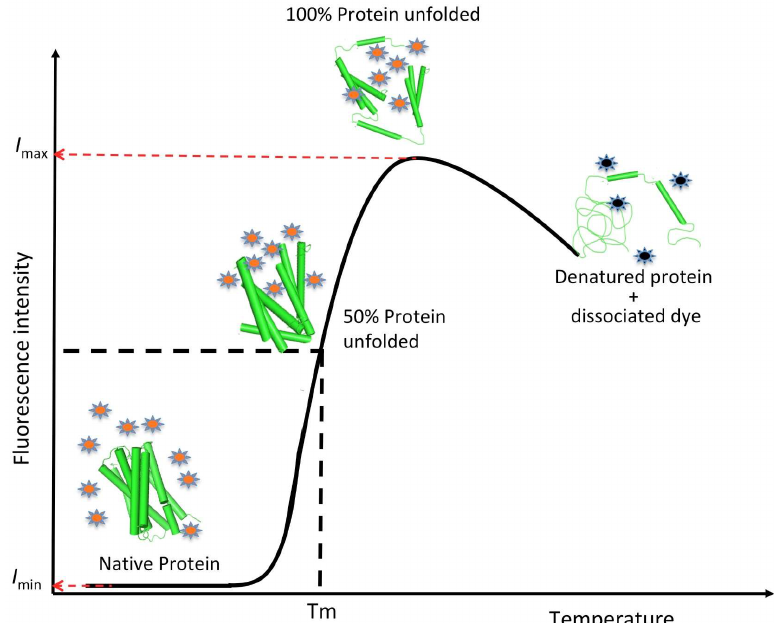
Figure 7. Graphic representation of a typical melting curve obtained during a differential scanning fluorimetry (DSF) experiment in the presence of a fluorescent dye. As the temperature increases, the protein unfolds and its intrinsic region becomes solvent-exposed, therefore, reacting with the fluorescent dye. The fluorescence intensity increases with the number of dye molecules binding the protein (in specific regions depending of the dye). The fluorescence intensity starts dropping with the protein denaturation and aggregation. The value of T m is calculated using Equation (5), where I max and I min correspond to the lower and upper limits of the curve, respectively.